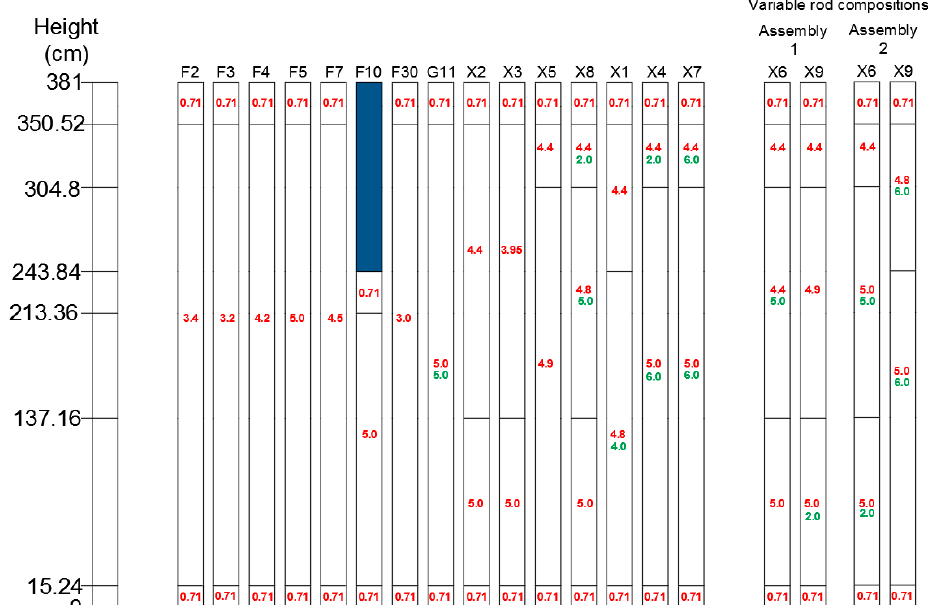
Figure 2. Axial pin description of the pins of both assembly one and two. Red representing the 235 U enrichment and green the weight percent of gadolinium oxide. Only pins X6 and X9 have their compositions vary between the two assemblies as highlighted. F10 represent a reduced height fuel pins, where the blue section represents water as a material.